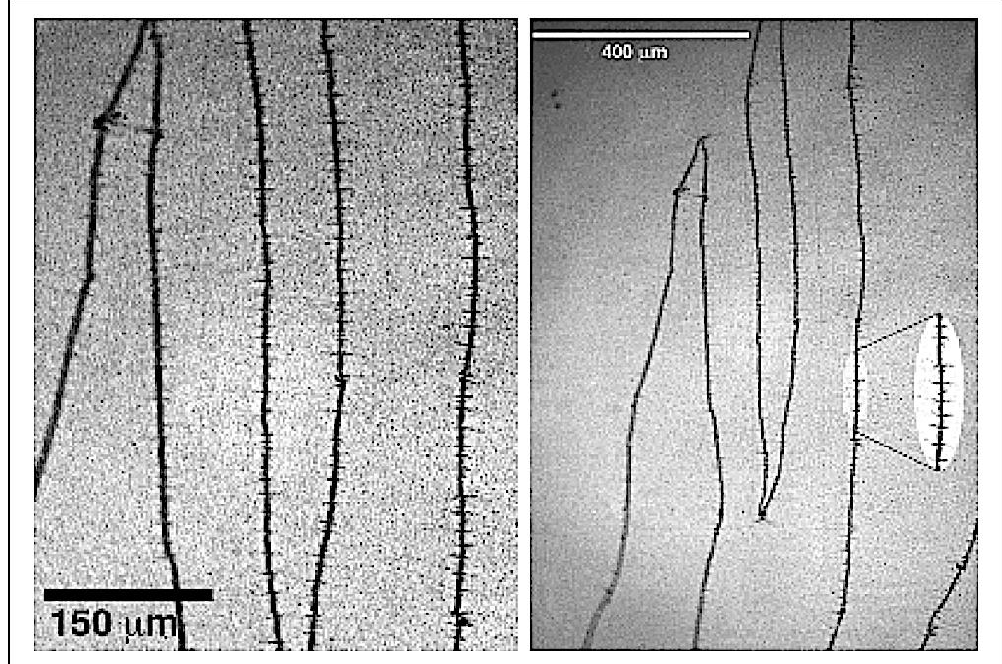
Figure 6. ( Left ): Details of magnetic microstructure of Fe film with t = 33 nm. Crosstie walls were observed within zigzag walls. ( Right ): Consecutive peaks corresponding to magnetic domain walls can be observed due to different image scales.